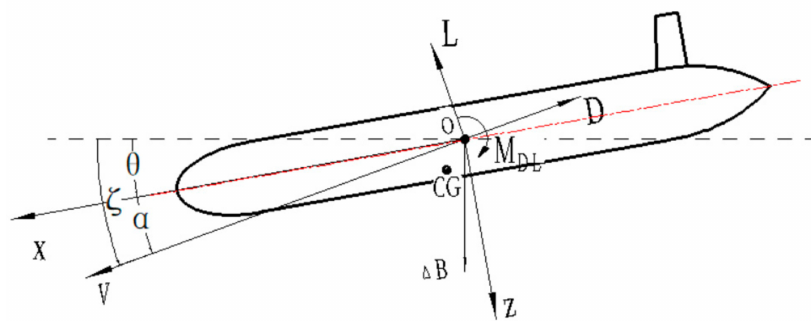
Figure 2. Force analysis of the